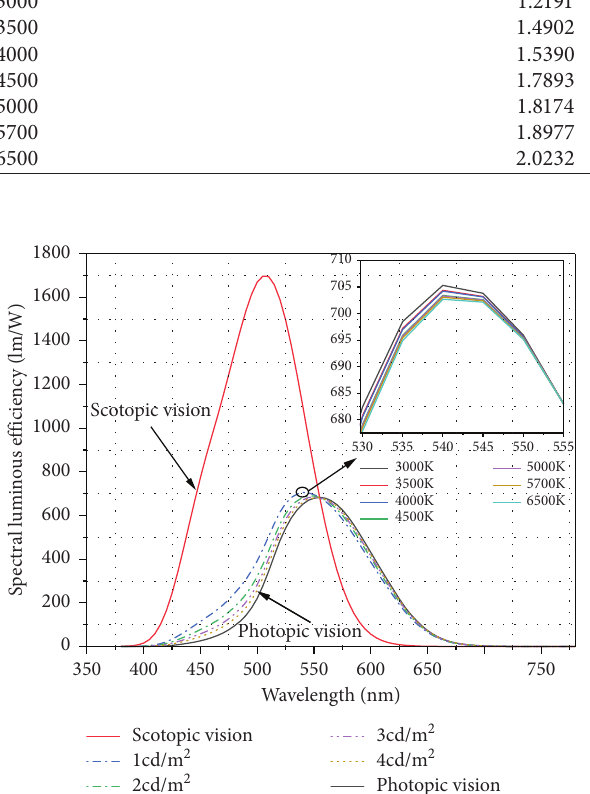
Figure 8: Spectral luminous efficiency curves of photopic, scotopic, and mesopic vision of seven kinds of LEDs with different